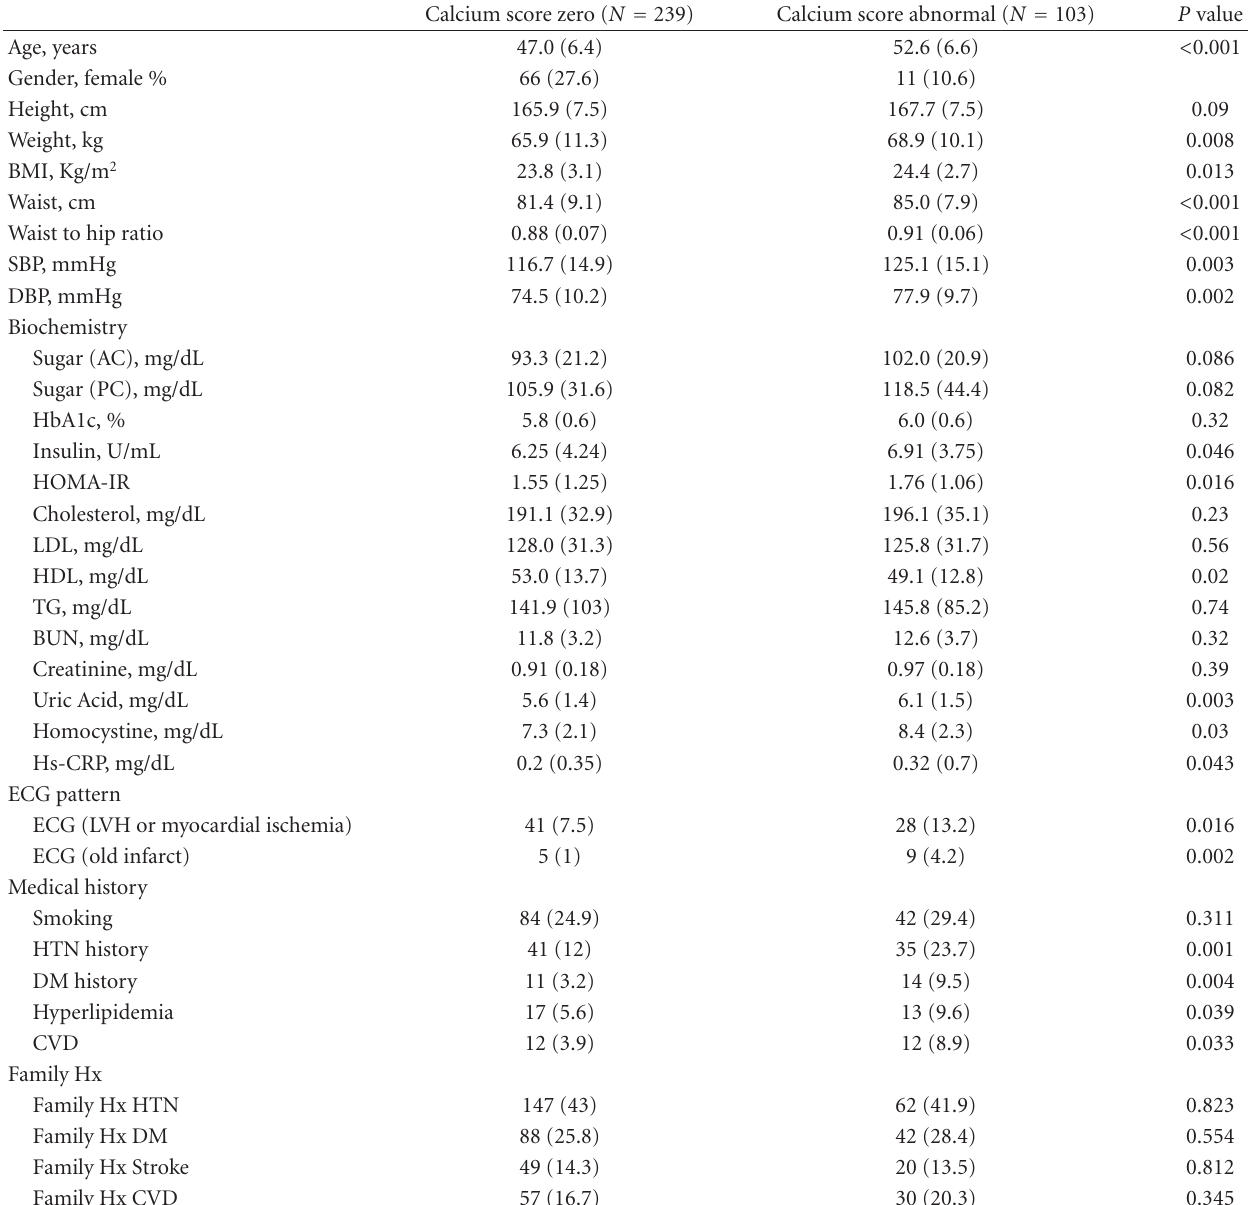
Table 1: Baseline demographic data and clinical information in our